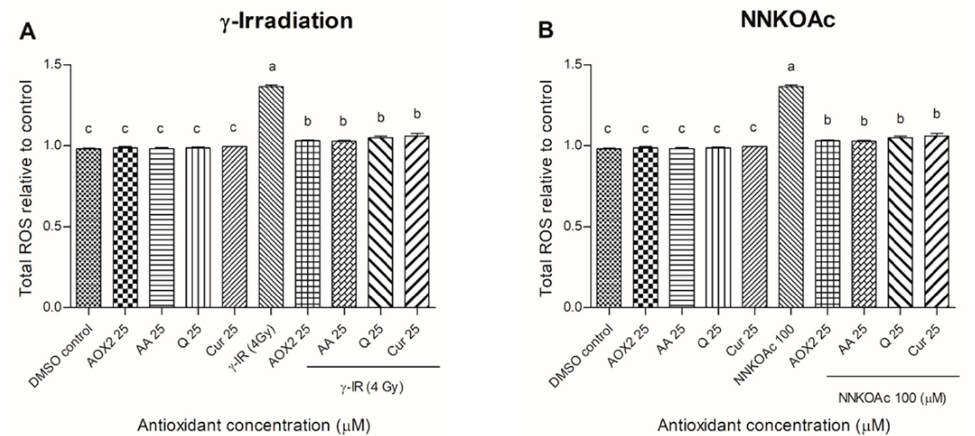
Figure 3. ROS production was reduced by pre-exposure to tested antioxidants in γ -irradiation ( A ) or carcinogen ( B ) induced BEAS-2B cells. Experimental values are mean ± SD of three independent experiments in triplicate. One-way analysis of variance was performed with Tukey’s pairwise comparison. Means that share the same letter are not significantly different at p ≤ 0.05. Abbreviations: AOX2, dietary antioxidant formulation-2; AA, ascorbic acid; Q, quercetin; Cur, curcumin; DMSO, dimethyl sulfoxide; γ -IR, γ -irradiation.